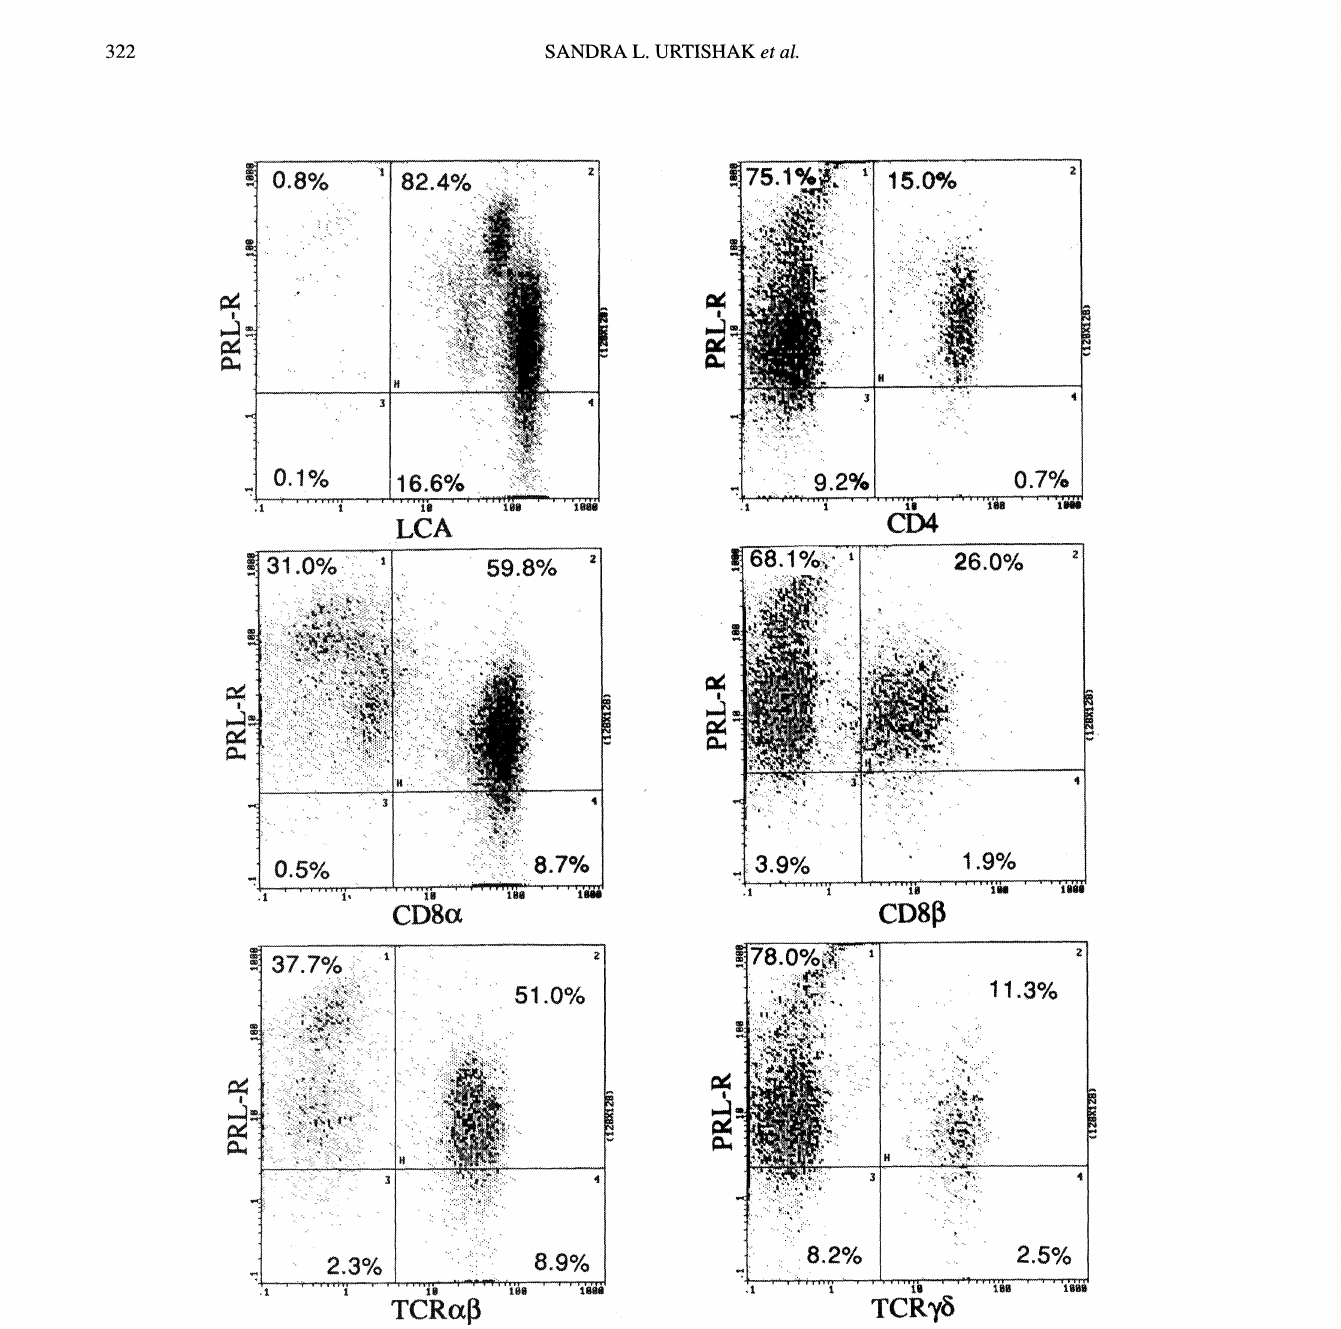
FIGURE 3 Dual labeling of IEL for PRL-R and lymphoid markers. IEL were isolated from the small intestine of Sprague Dawley rats and analyzed by flow cytometry on a Coulter XL2 flow cytometer with Elite software as described in the methods section. LCA expression was used to gate the lymphocyte population. Data from a 96 day male rat are shown